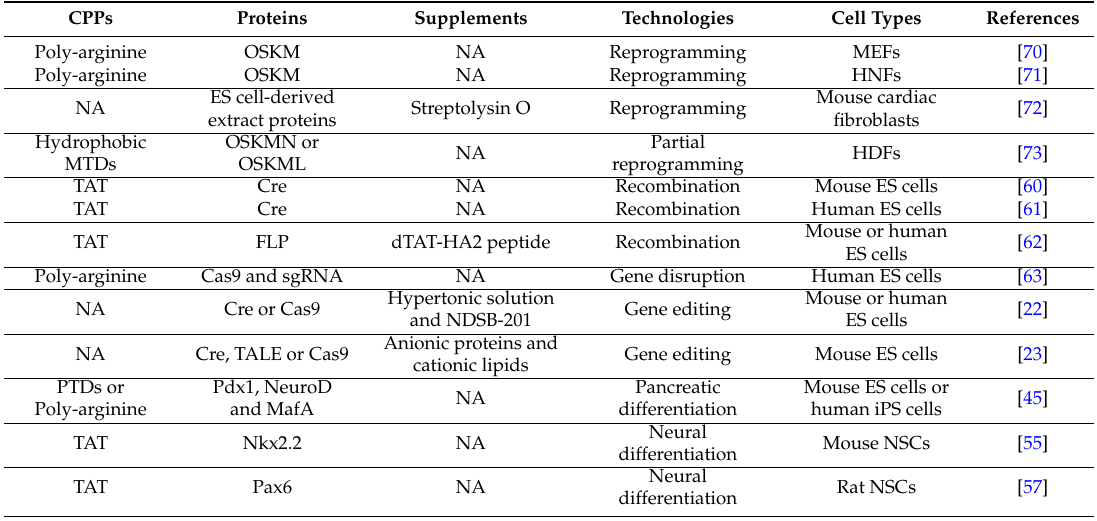
Table 1. Summary of pluripotent stem cell technologies via protein transduction